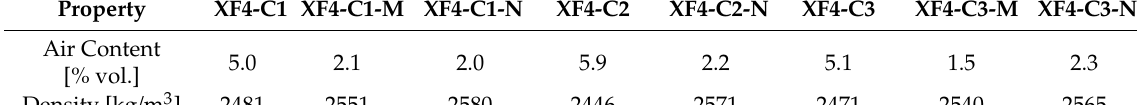
Table 8. XF4 concrete mixtures test results.